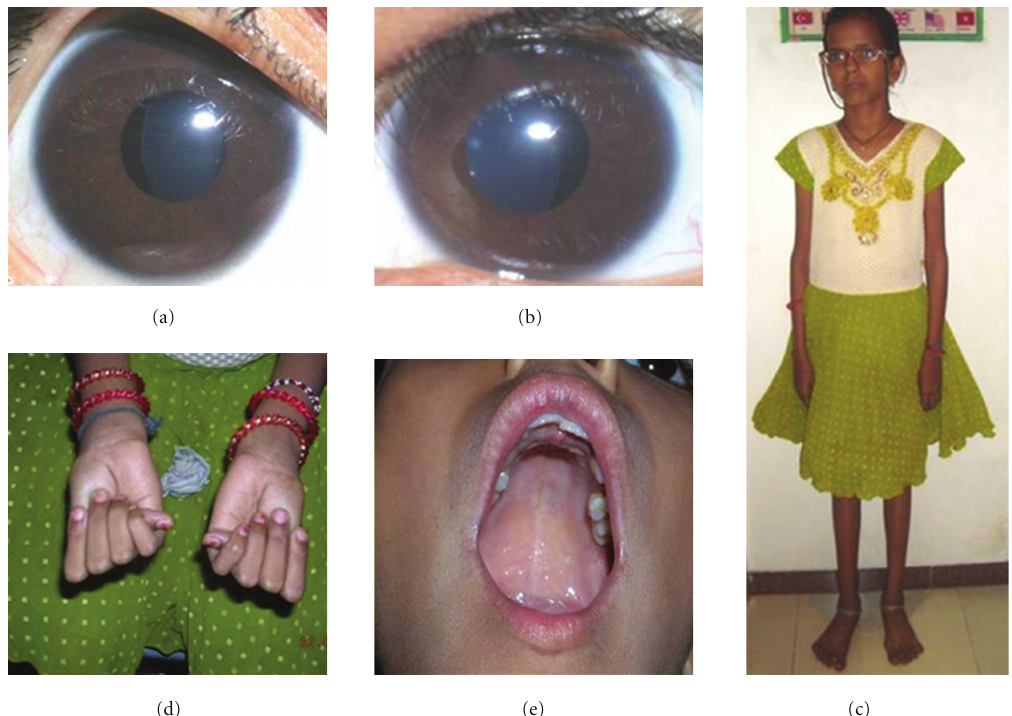
Figure 2: Features suggestive of MFS. (a) Nasal subluxation of crystalline lens in the right eye and (b) in the left eye, (c) tall and thin stature with long arms, (d) positive thumb sign and arachnodactyly, (e) high arched palate with crowding of